Question: Looking at the figure, what chart type is it?
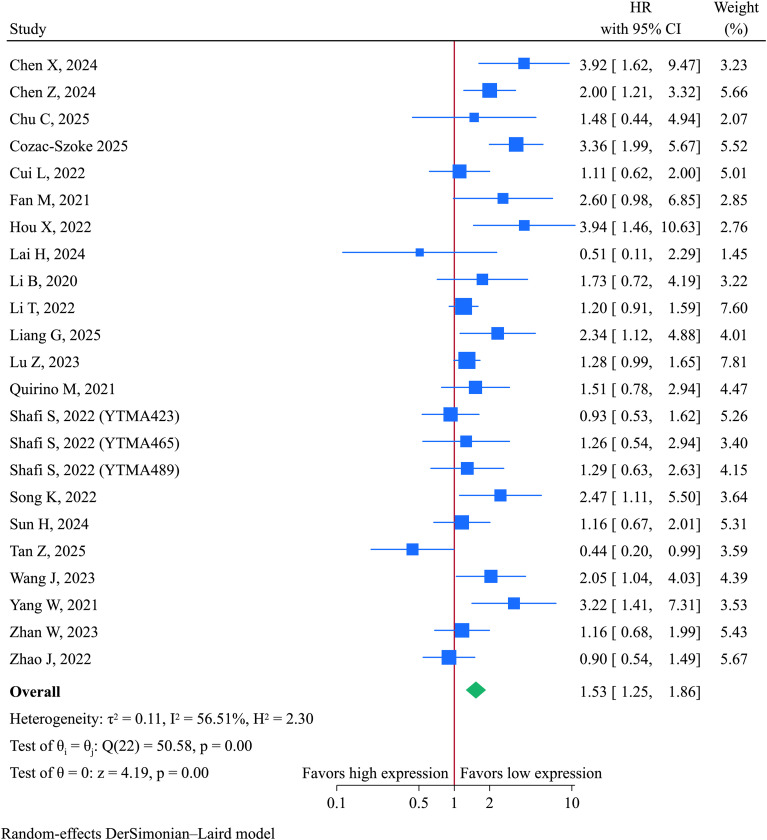
Answer: forest